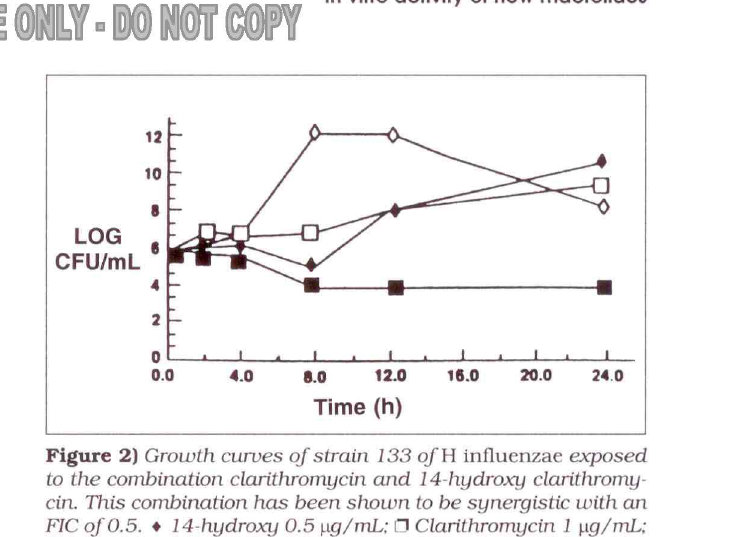
Figure 2) Growth curves of strain 133 ojH influenzae exposed to the combination clarithromycin and 14-hydroxy clarithromy cin. This combination has been shown to be synergistic with an FIC oj0.5. • 14-hydroxy 0.5 ~tg/rnL: 0 Clarithromycin 1 ~tg/mL: • Clarithromycin 1 119/ rnL + 14-hydroxy 0.5 pg/ rnL: 0 Growth without antibiotic TABLE 5 Range and MIC9o (mg/ L) of macrolides against H intlu enzae